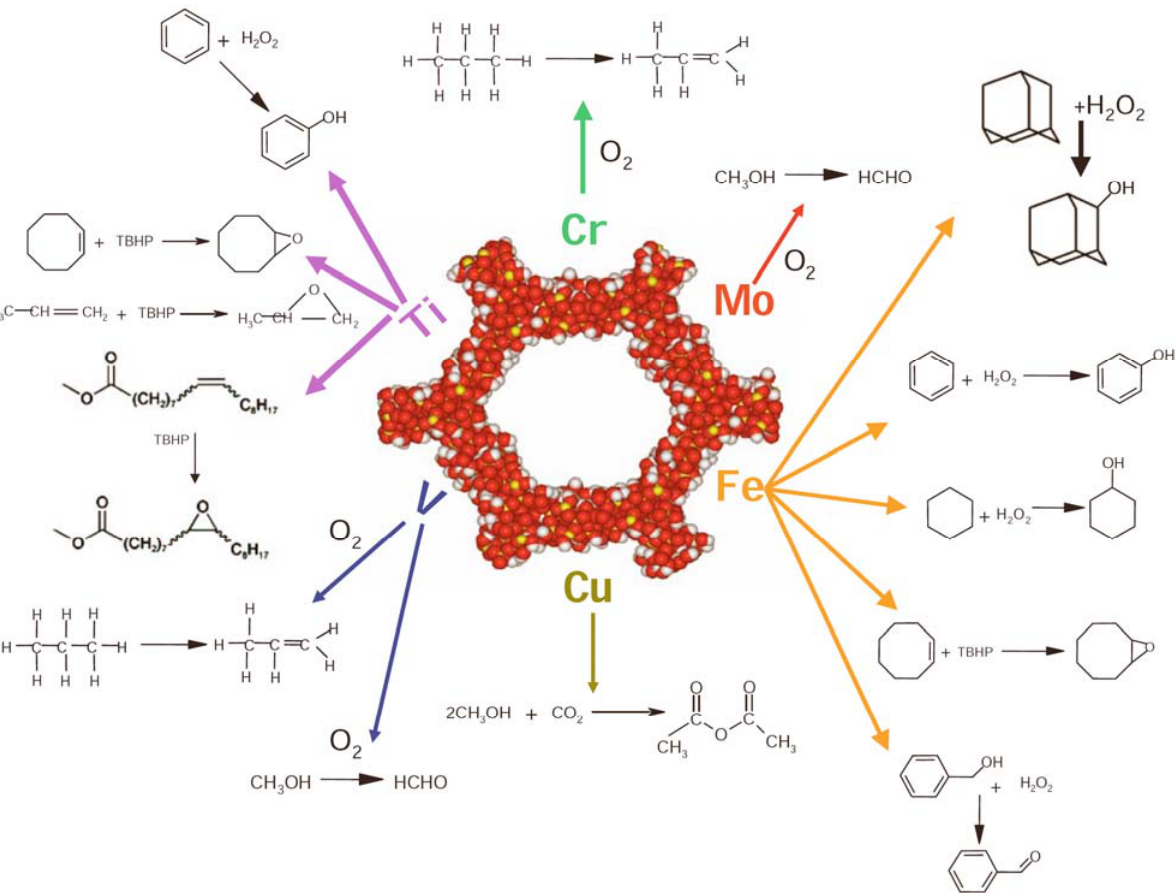
Figure 8. Some selective oxidations that can be carried out over SSHC obtained by depositing various metal centres onto the surface of hexagonal mesoporous silica. From Ref. [6], reproduced with kind permission of Springer Science and Business